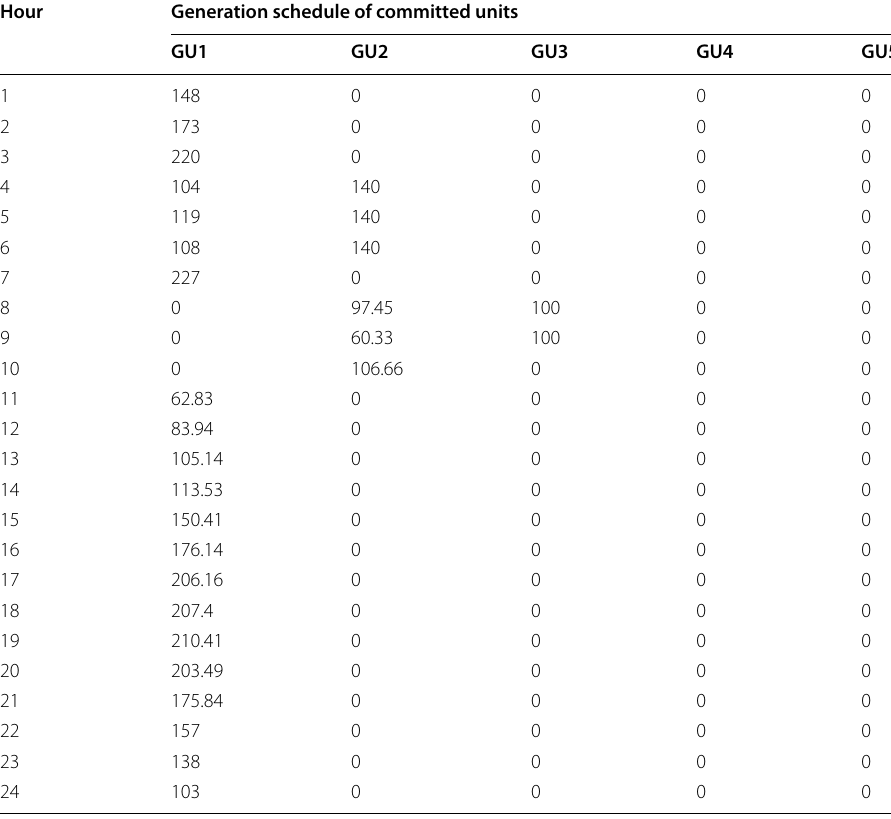
Table 2 Power scheduling for 5 generating system considering renewable energy in summer